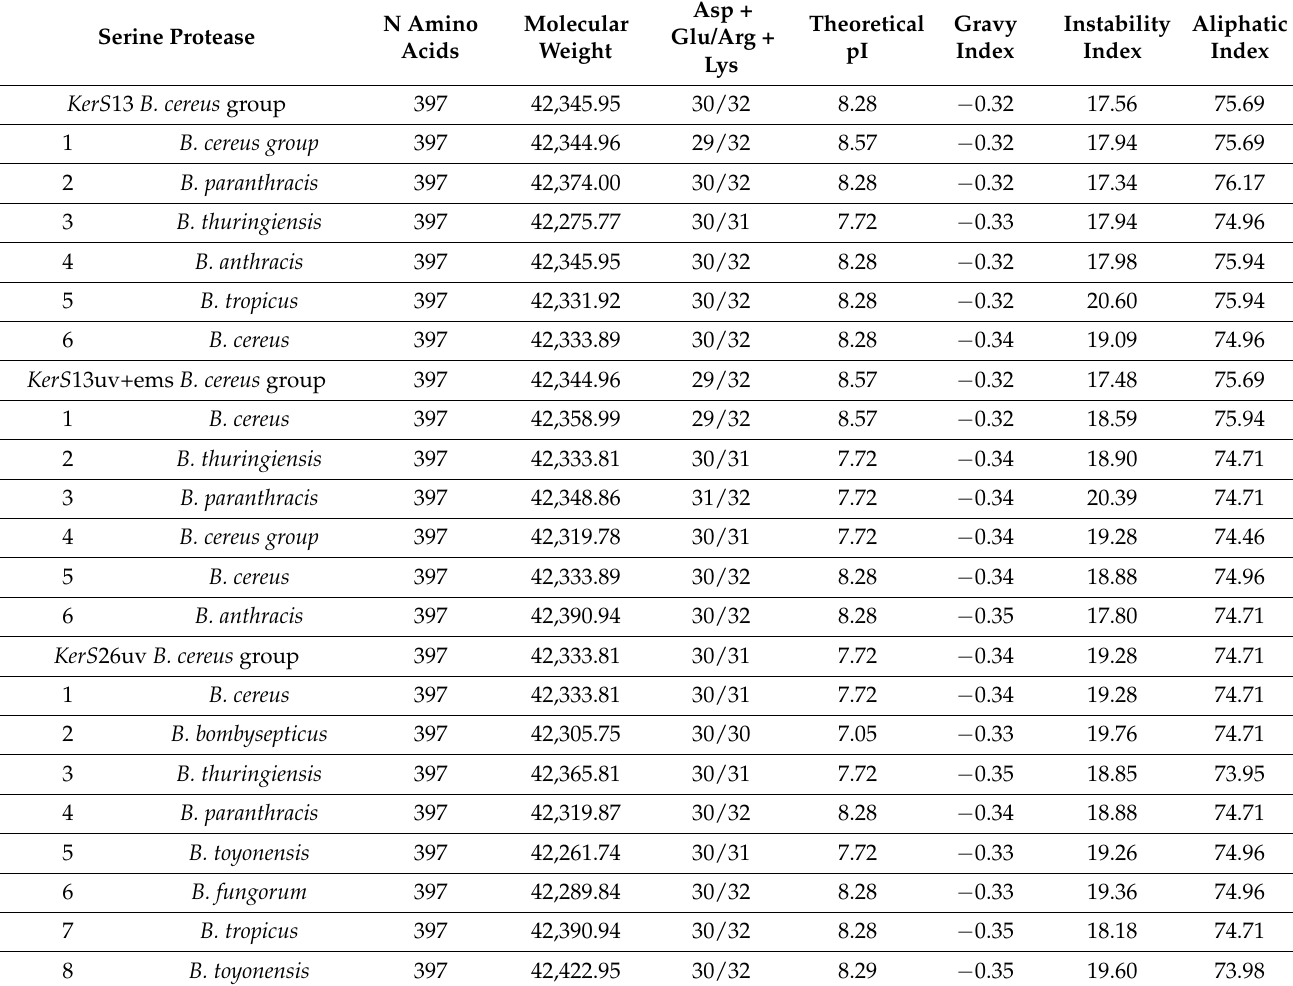
Table 2. Physiochemical properties of keratinase KerS primary structure compared with the similar serine proteases of B. cereus group retrieved from GenBank database.